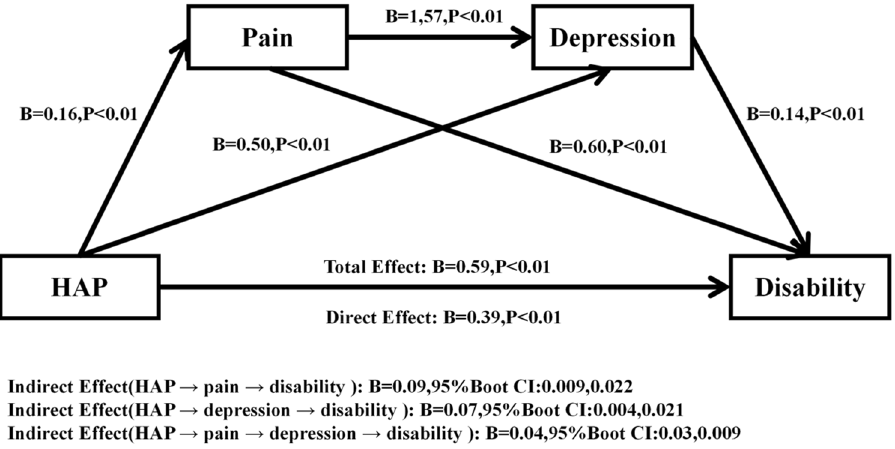
Figure 3. A serial mediation model of the association between HAP and disability through pain and depression (N = 5471). Path coefficients are shown. Mediation analyses were performed with 5000 bias-correct bootstrapped